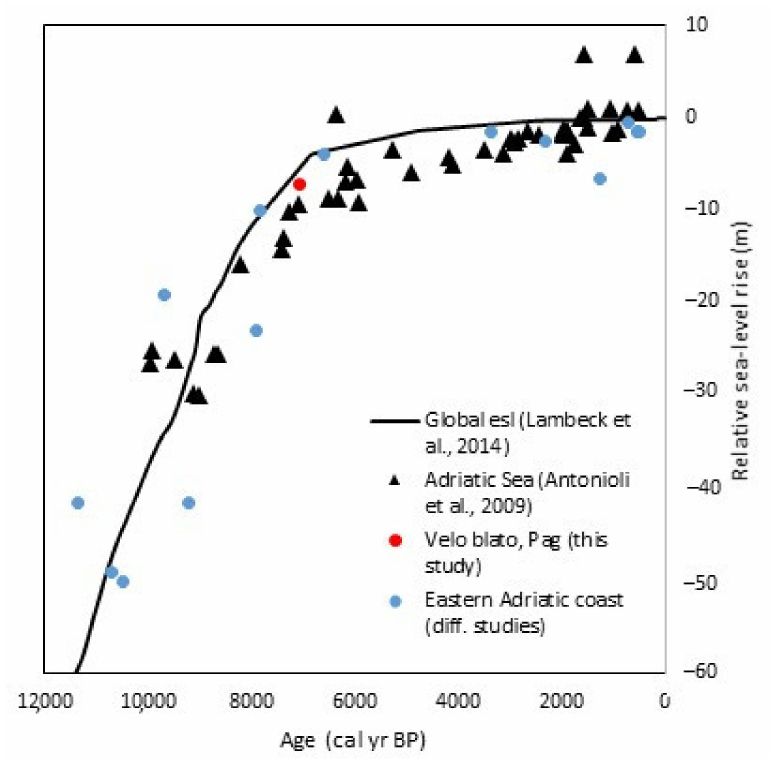
Figure 14. Relative sea-level rise during the Holocene in the Adriatic Sea [107] in relation to the global eustatic sea-level (esl) curve [106], and index points from this study (red dot) and other studies on the EAC